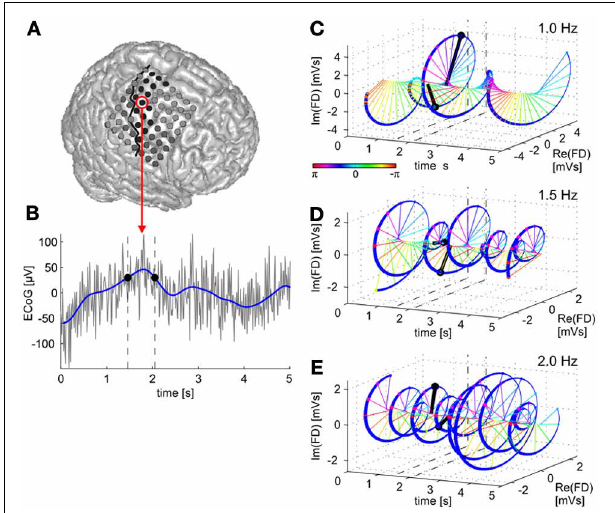
FIGURE 1 | Time domain vs. time-frequency domain representations of the ECoG low-frequency component (LFC). A raw brain signal recorded from a site over premotor cortex (A) is shown in (B) (gray curve). The LFC in the time domain is derived by low-pass filtering (blue curve). Two LFC values with the same amplitudes are indicated by black dots at their respective time points indicated by dashed vertical lines. The LFC data can be transformed to an equivalent, complex valued, time-frequency representation, given by the time course of magnitude and phase values of oscillatory components at different frequencies within the LFC band. In (C) , the time course of the 1.0-Hz oscillatory component of the brain signal is shown. Data vectors at the same two time points as indicated in (B) are drawn in black, signal magnitude corresponds to the length of a vector and phase to its angle (color-coded) in the complex space. Note that both magnitude and phase at the two selected time points in (B) are now different. The 3D figure shows time ( x -axis) and real ( y -axis) as well as imaginary ( z -axis) components of the signal’s Fourier descriptors (FDs). (D,E) —the same for the 1.5-Hz and 2.0-Hz oscillatory components, respectively. In the present study, we examined trajectory encoding and decoding of ECoG signals based on such time-frequency representations to determine the contributions of magnitude and phase information,